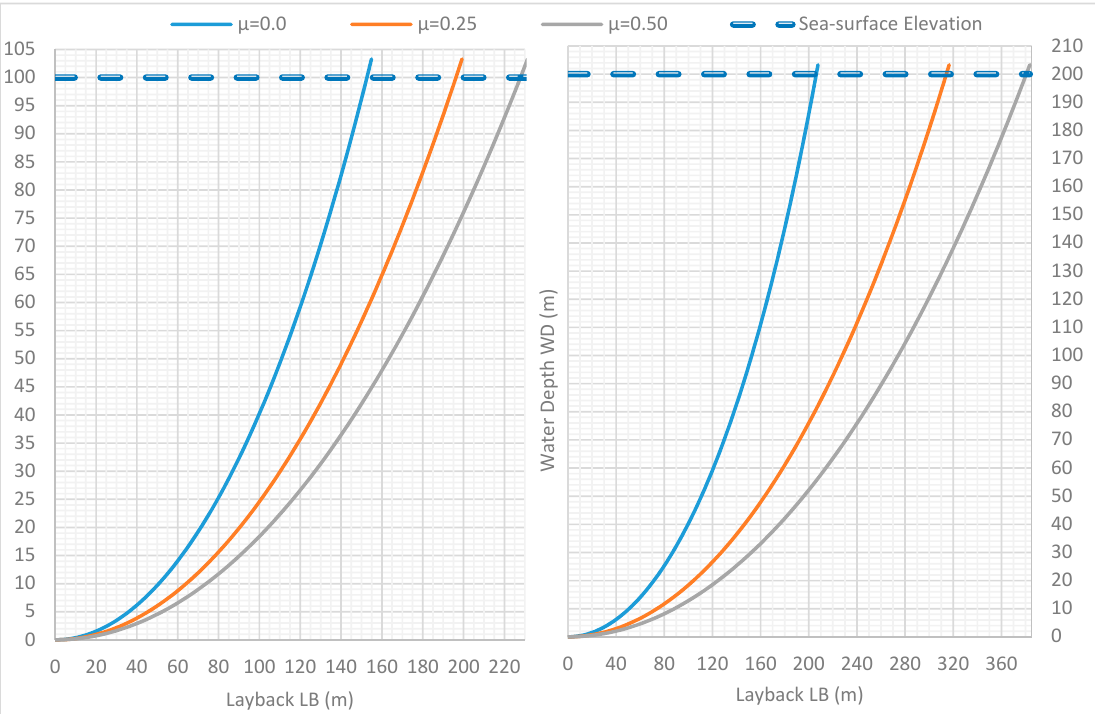
Figure 24. Cable configuration for CS2 assuming different friction coefficients at 10 m and 50 m water depth.